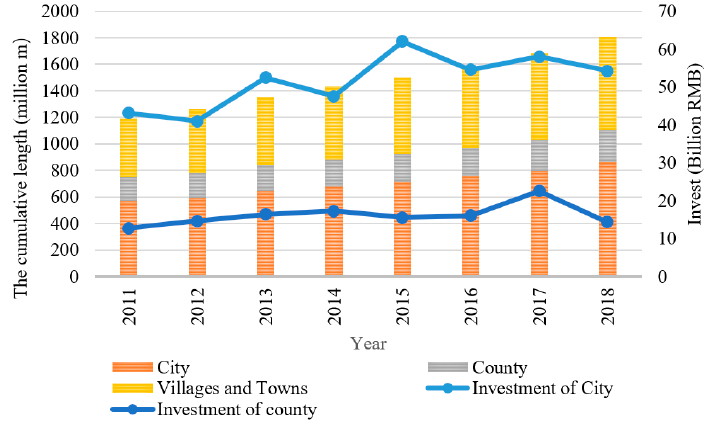
Figure 1. The changing of water-supply pipe network market in China in recent years.